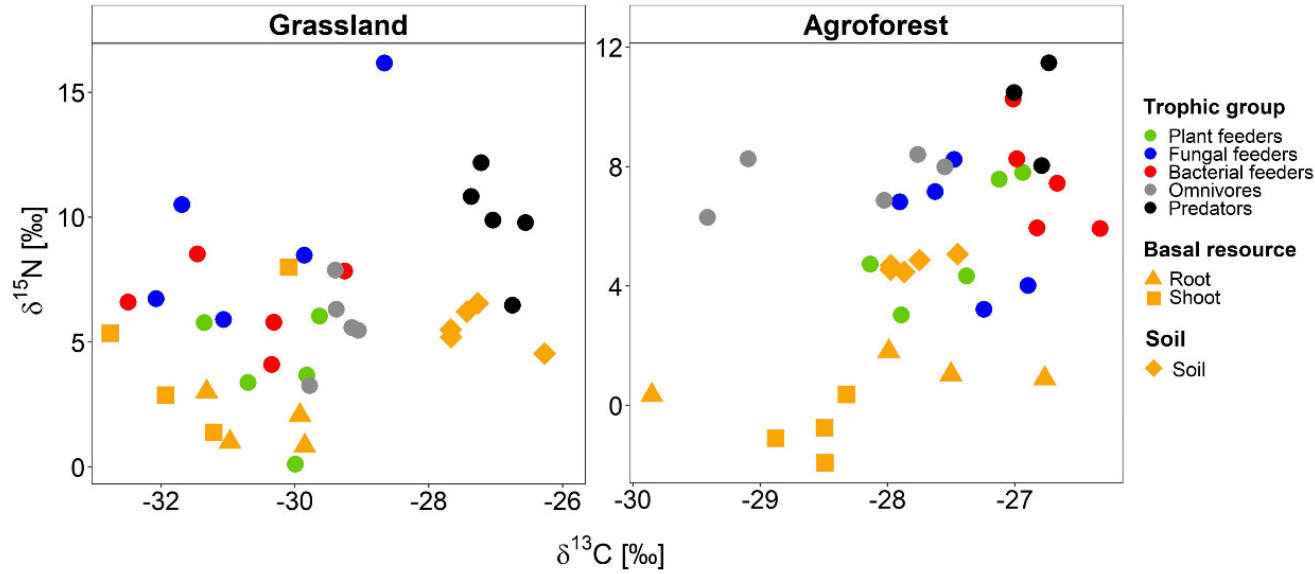
Figure 1. Natural stable isotope signatures of C (‰ δ 13 C) and N (‰ δ 15 N) of the soil, the basal plant resources shoots and roots, and in nematode trophic groups in grassland and agroforest systems.